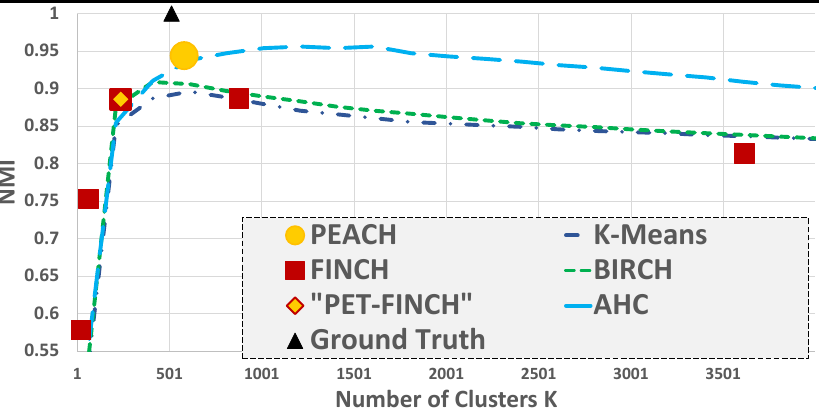
Figure 3. EVT-based Threshold Works Well. We show multiple clustering algorithms’ NMI performance on the IJB-B 512 face